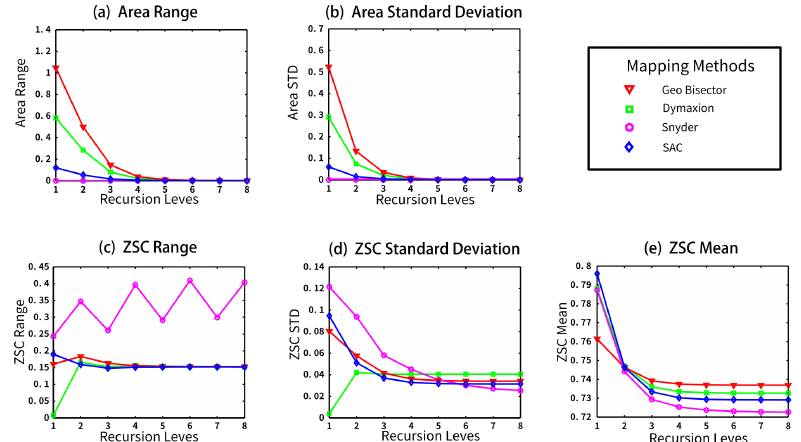
Figure 18. Graphs of the five statistics of the area and Zone Standardized Compactness (ZSC) response measurements for each method as a sequence by recursion level (level 1 to level 8). These results are for the tetrahedron using the 4-fold density